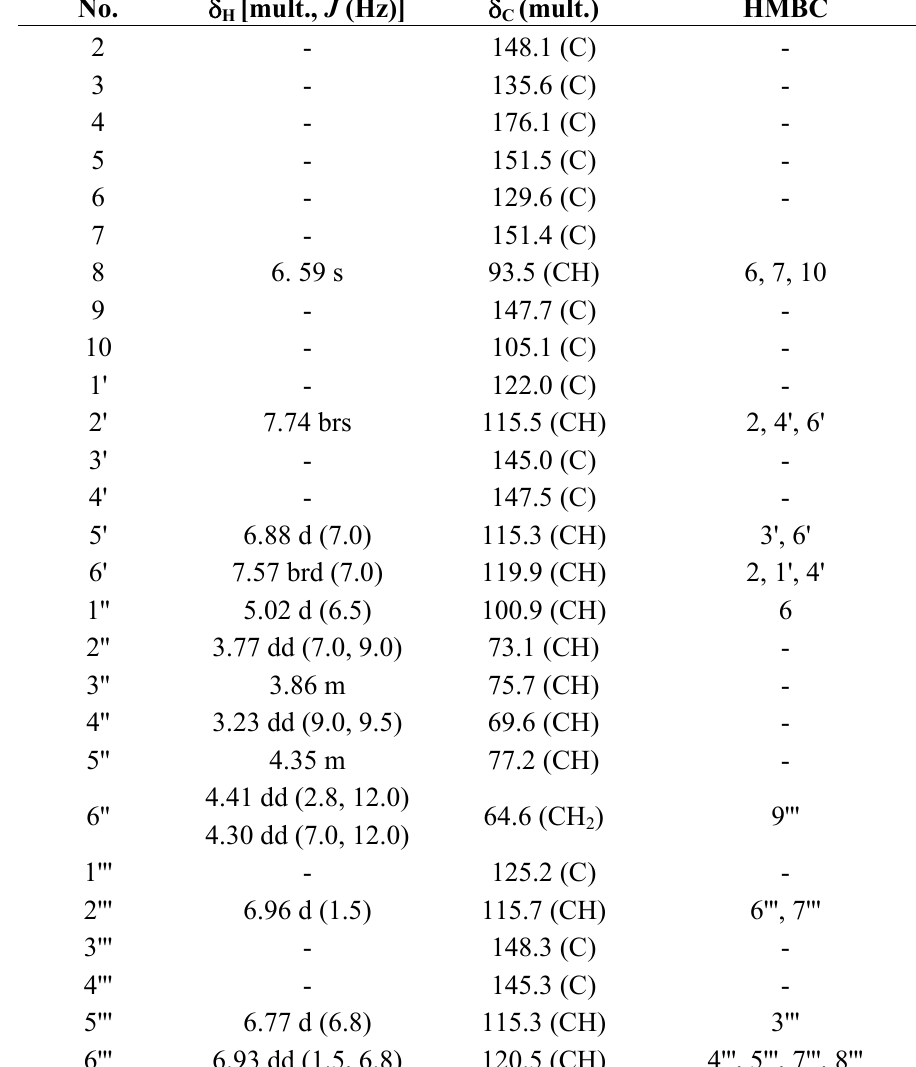
, 500 and 125 MHz). 6